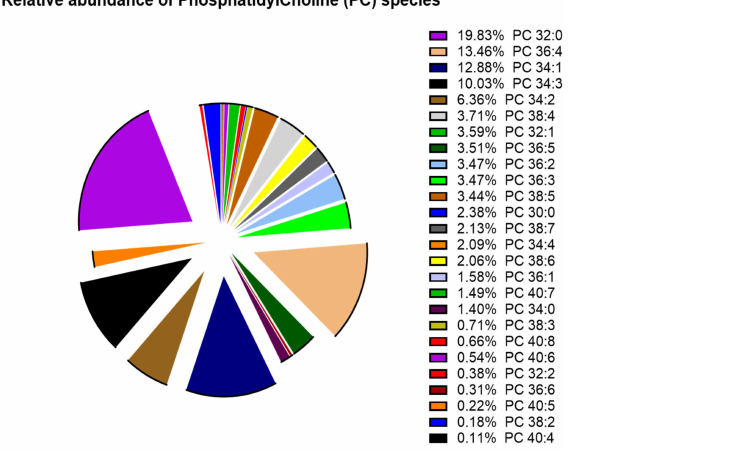
Figure 1. Relative abundance of phosphatidylcholine (PC) species in lungs from control. After total lipids were extracted, the relative abundance of phosphatidylcholine (PC) species was analyzed by mass spectrometry.